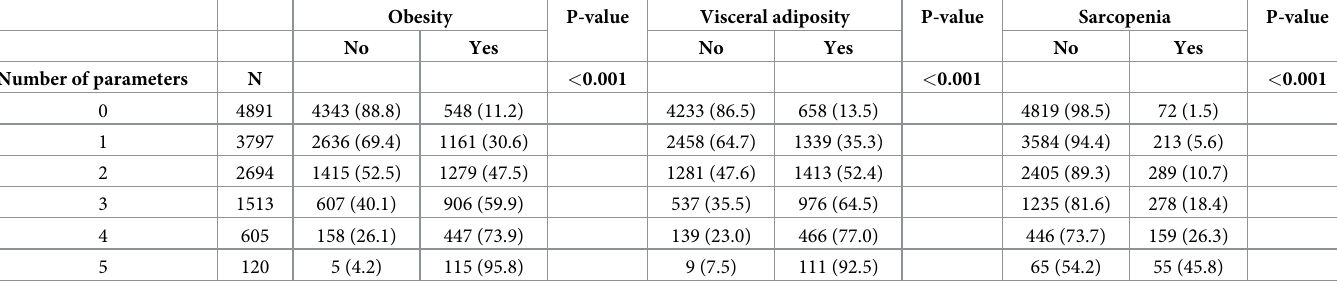
Table 3. Comparisons of number of metabolic parameters according to obesity, visceral adiposity, or sarcopenia.